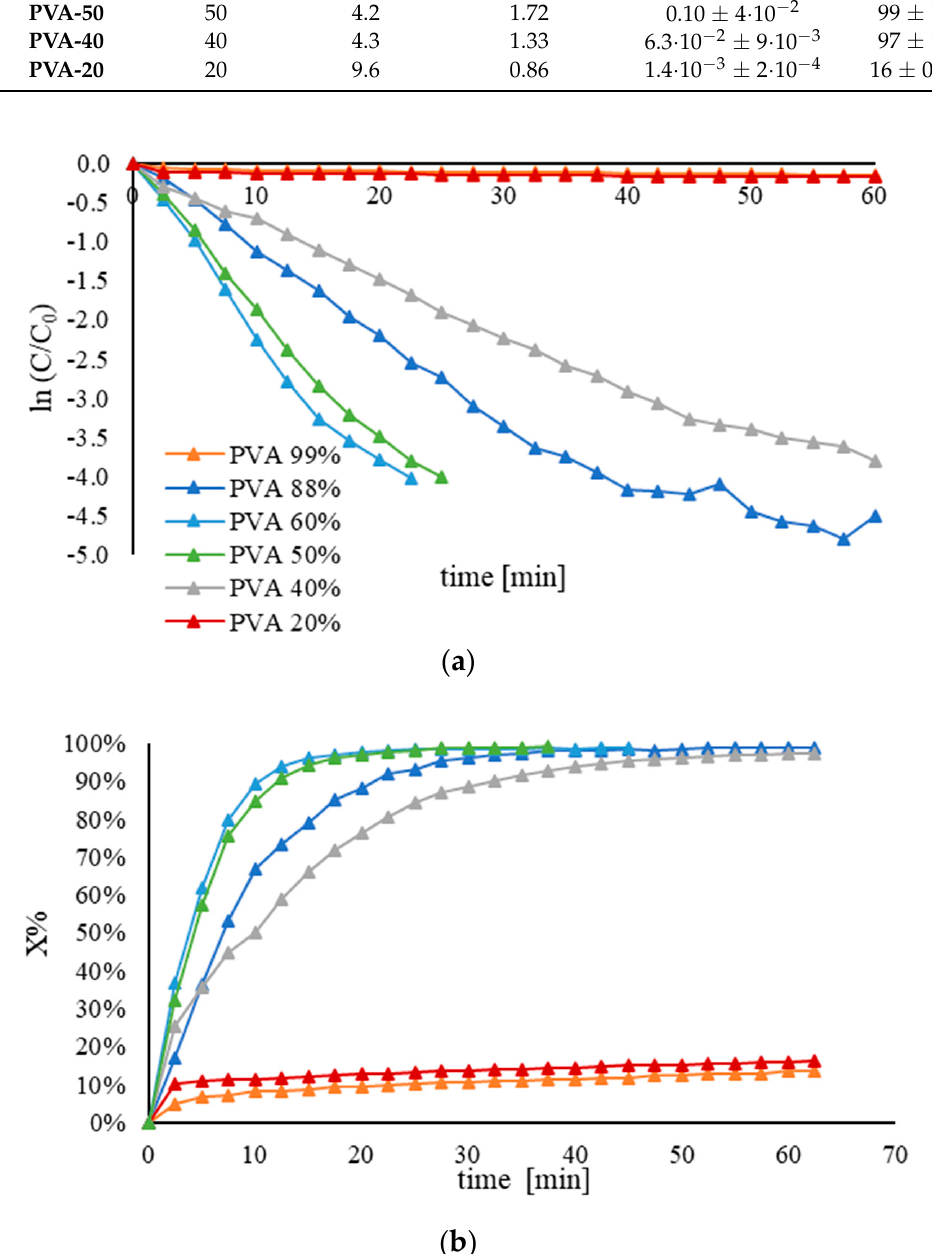
Figure 4. ( a ) Pseudo – first − order kinetic plot and ( b ) conversion plot for the comparison of the activity of Au/AC synthesized using PVA with different hydrolysis degrees. The reduction of 4–NP was carried out using 25 mL of 4–NP (2 × 10 –4 M), 25 mL of NaBH 4 (9.0 × 10 − 3 M), an Au/PVA weight ratio of 1:0.65, 4 mg of catalyst, at 25 °C.